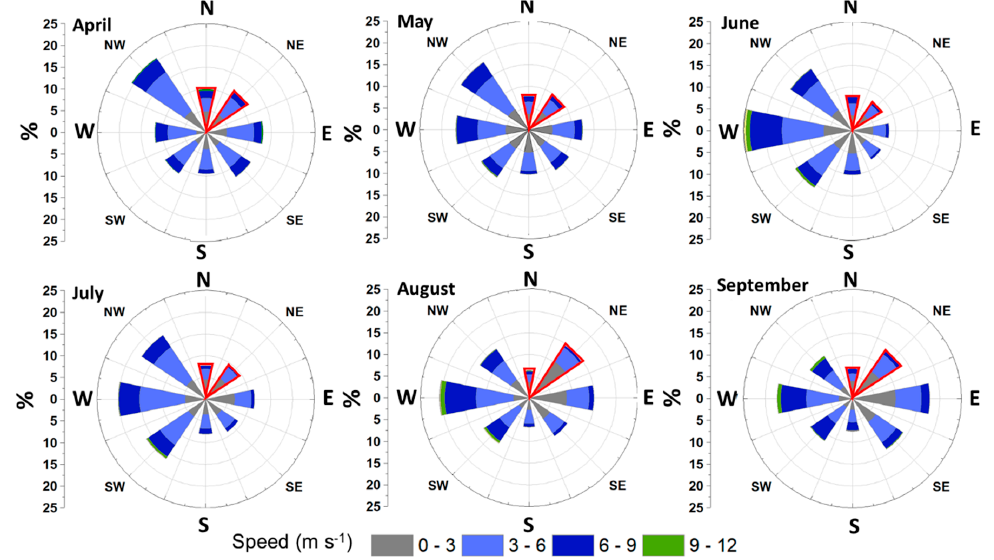
Figure 4. Monthly wind roses for April–September 2000–2015, based on the data from the Klaipeda coastal meteorological station. Wind directions framed in red indicate upwelling favorable winds.